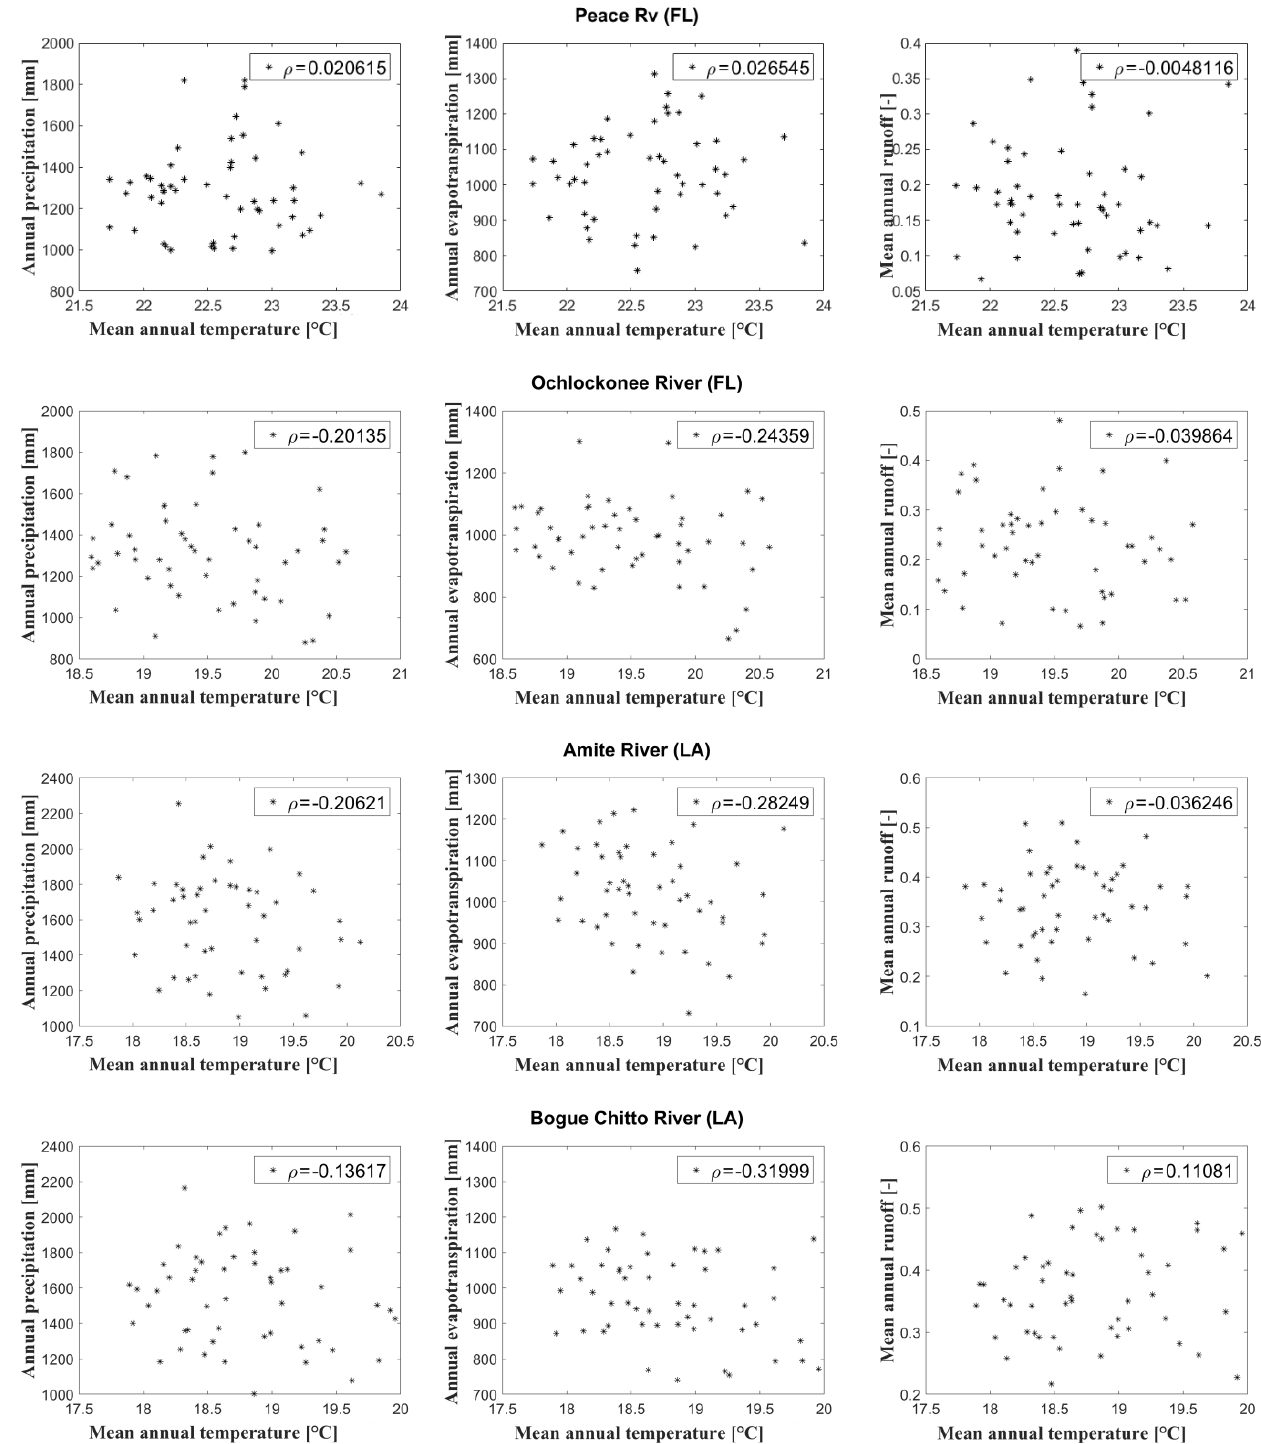
Figure 2. Annual precipitation against mean annual temperature (left panels), annual evapotranspiration against mean annual temperature (middle panels) and annual runoff coefficient against mean annual temperature (right panels) for four different basins: Peace River (FL), Ochlockonee River (FL), Amite River near Denham Springs (LA), and Bogue Chitto River (LA). In each plot, the Pearson correlation coefficient ρ is reported in the